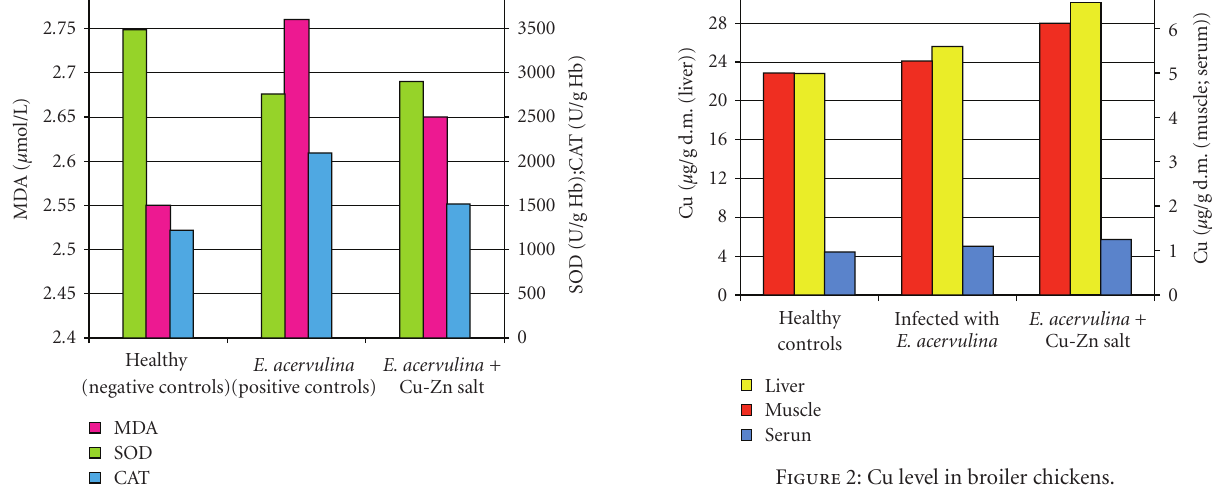
Figure 2: Cu level in broiler chickens.